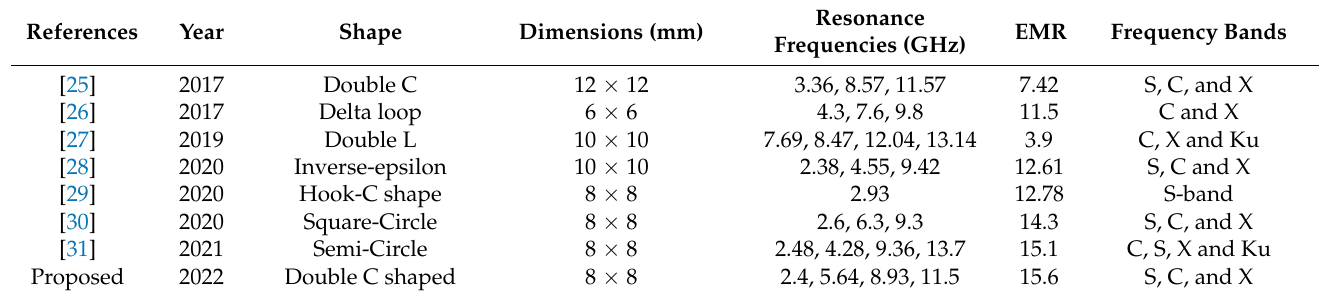
Table 4. Comparison between proposed metamaterial and recently developed metamaterials based on resonance frequencies, dimension, and